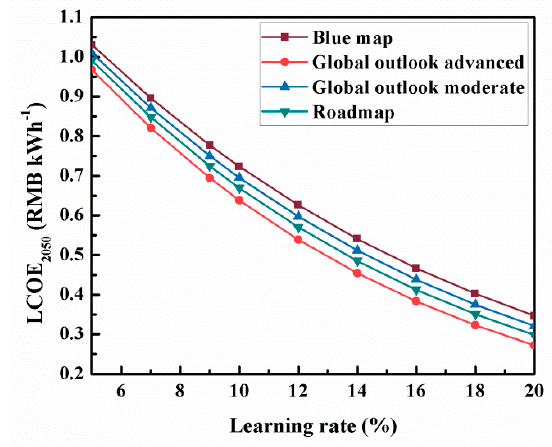
Figure 9. E ff ect of learning rate on the LCOE for four Figure 9. Effect of learning rate on the LCOE for four scenarios.